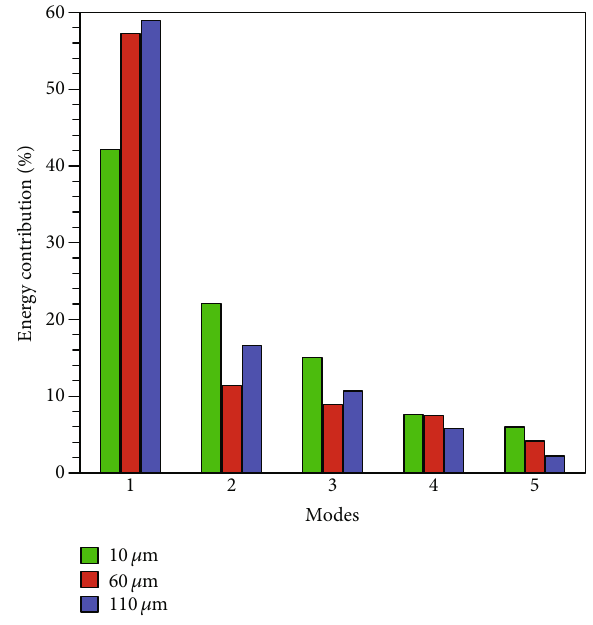
Figure 18: Energy contribution of the top fi ve modes for di ff erent initial LOX particle